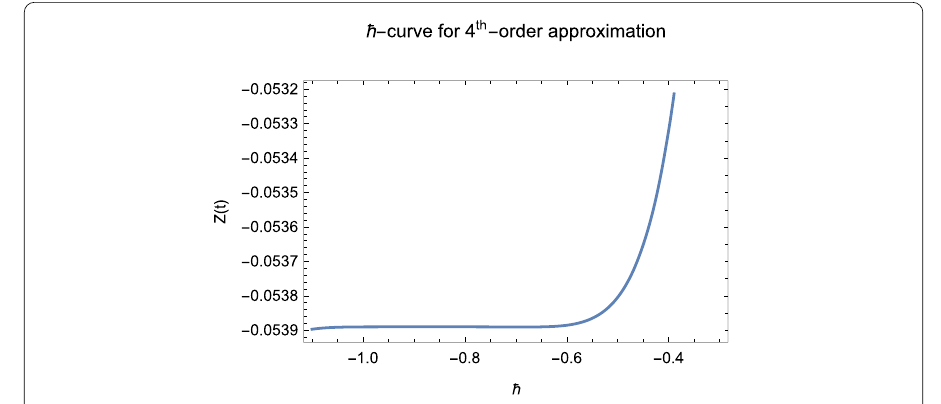
Figure 9 The h -curves of the fourth-order approximations for Z ( t )